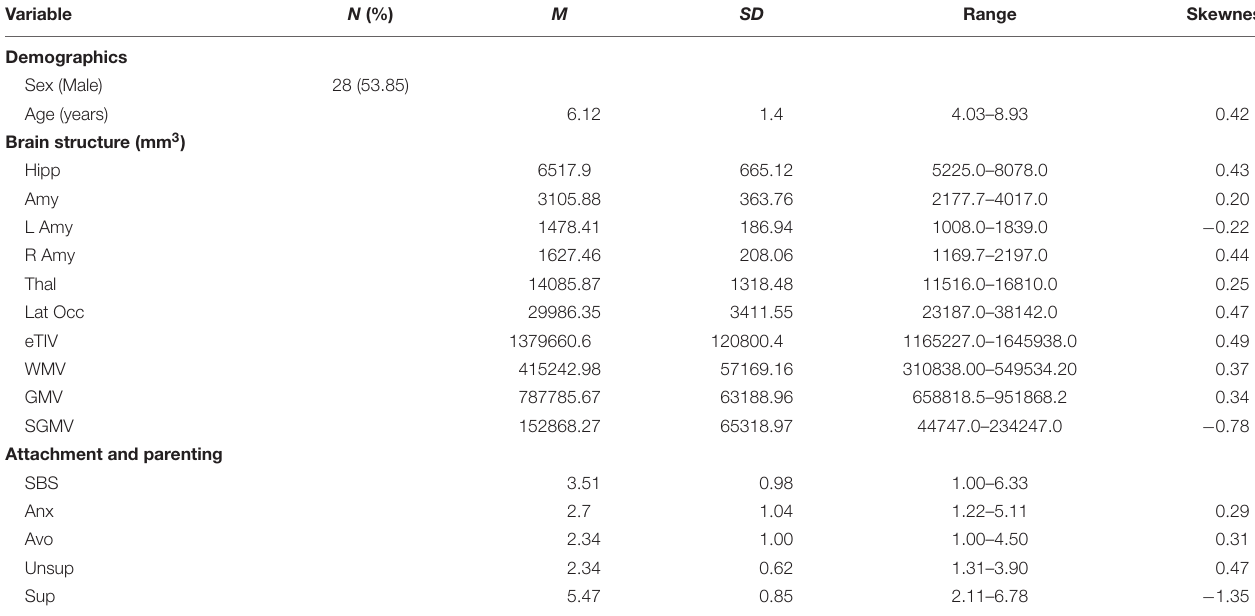
TABLE 3 | Descriptive statistics of main study variables.